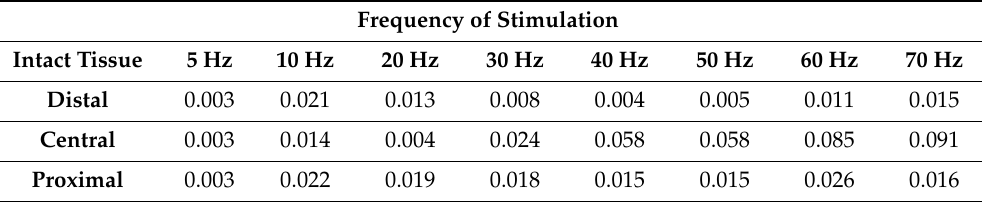
Table 1. Amount of calculated force (grams) generated by the intact tissue.